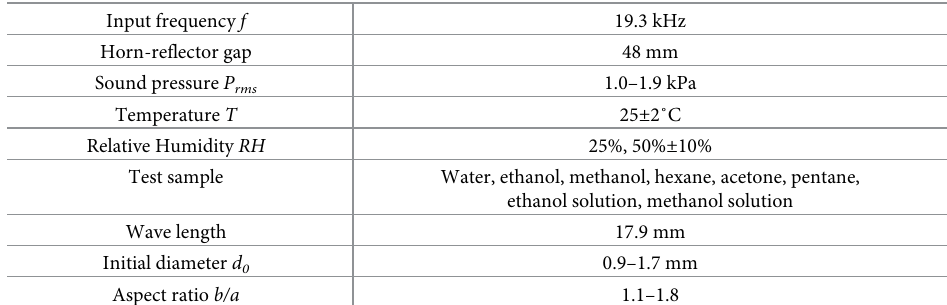
Table 1. Experimental